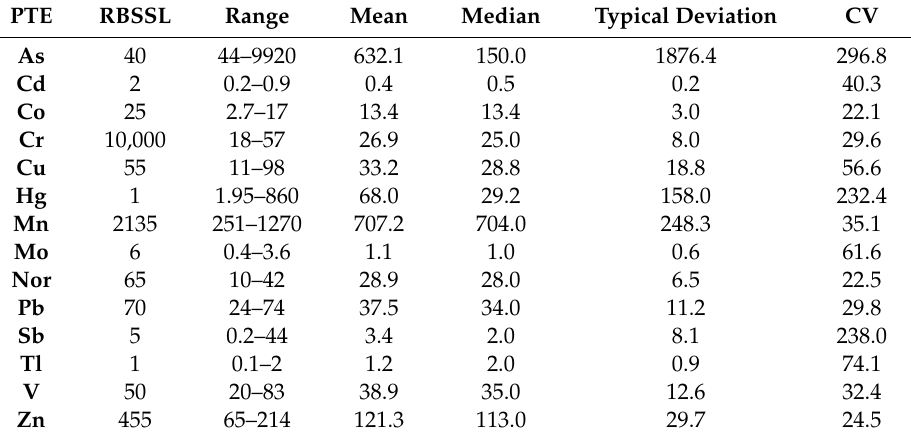
Table 1. Descriptive statistics for the 27 soil samples analyzed. Concentrations expressed as mg / kg. PTE RBSSL Range Mean Median Typical Deviation CV As